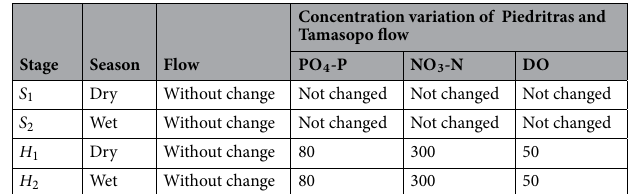
Table 3. Formulation of the simulation